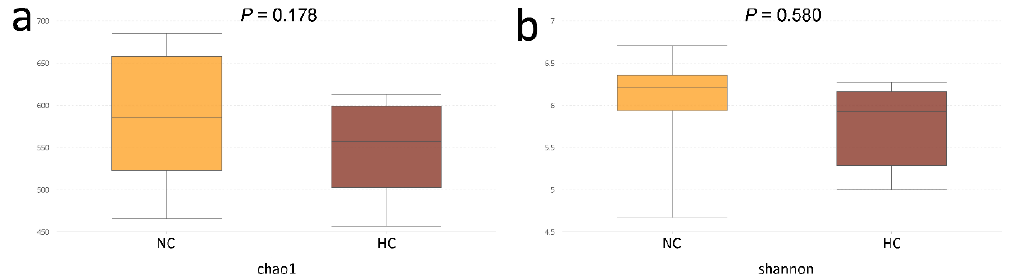
Figure 1. Alpha-diversity of intestinal bacterial community of goats fed normal-concentrate diet (NC) and high-concentrate diet (HC). ( a ) The bacterial richness in the ileum estimated by the Chao 1 value. ( b ) The bacterial diversity in the ileum estimated by Shannon index.